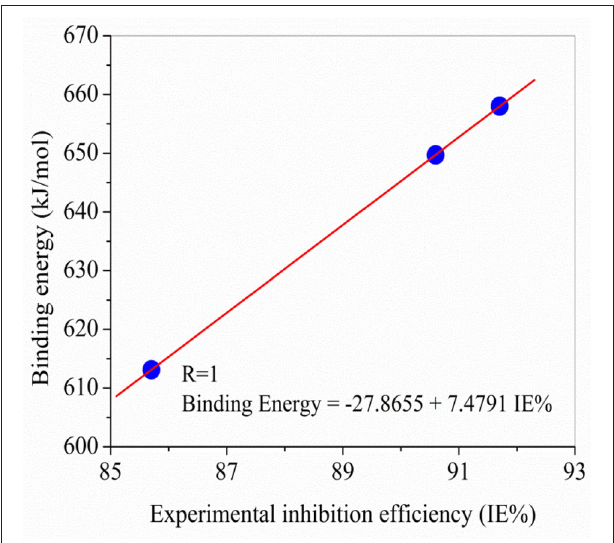
FIGURE 6 | Graphical representation of the linear relationship coefficient ( R ) obtained between the calculated reactivity descriptors and the experimental inhibition efficiency ( IE %). (A) in gas phase and (B) in aqueous phase.